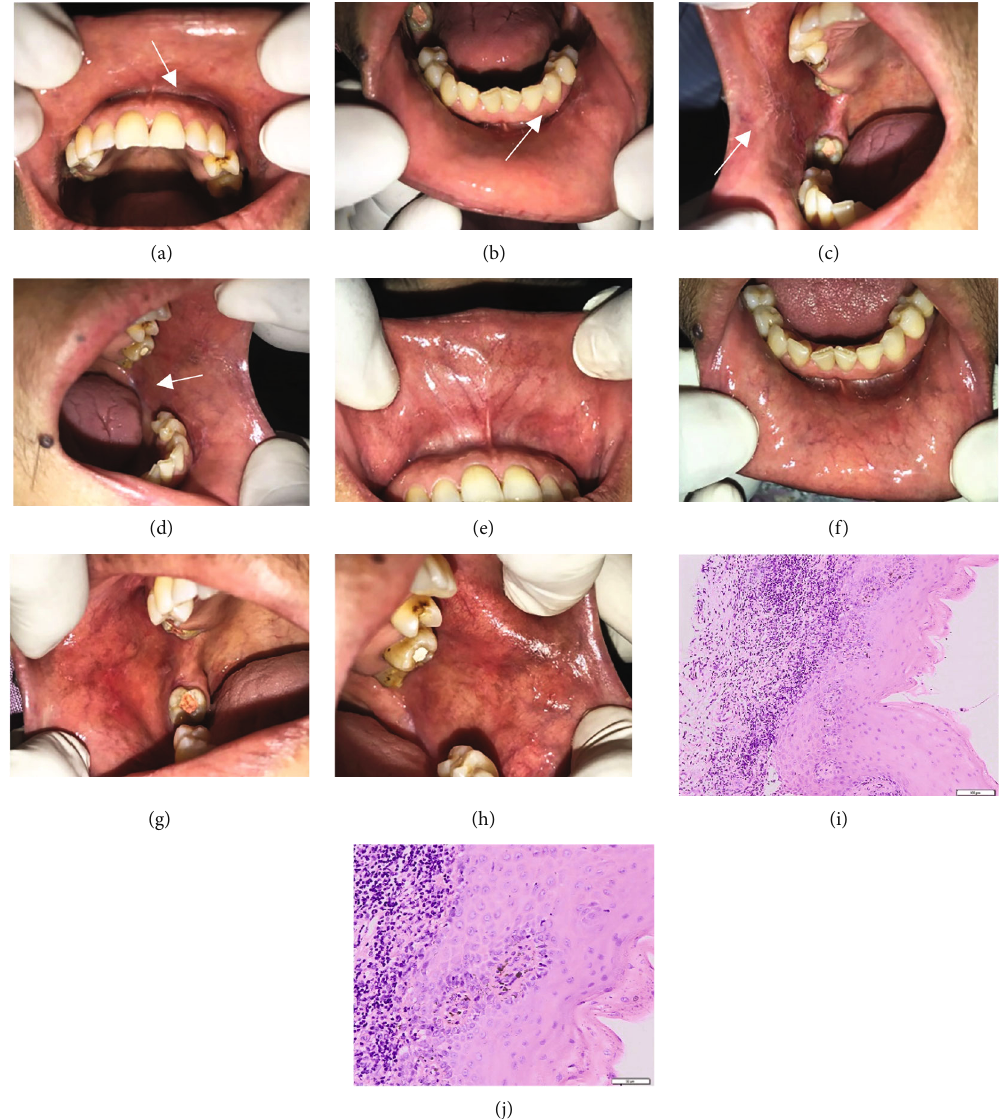
Figure 5: The clinical features of OLP in a 54-year-old woman; (a) and (b) erythema with radiating white striae on the upper and lower labial mucosa; (c) and (d) Wickham striae on the lower left labial mucosa and on the left buccal mucosa; (e) – (h) lesion on the upper and lower labial mucosa and the right and left buccal mucosa showed a signi fi cant improvement; (i) and (j) histopathological features of the lesion with 100x and 400x magni fi